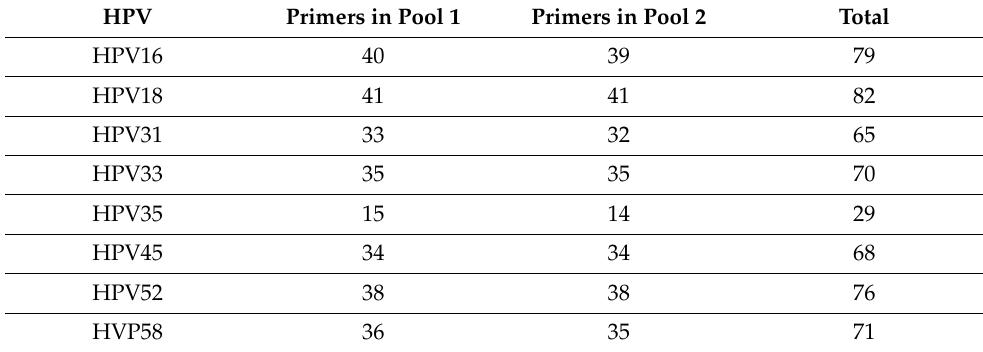
Table 1. Details of panHPV-detect panel primer